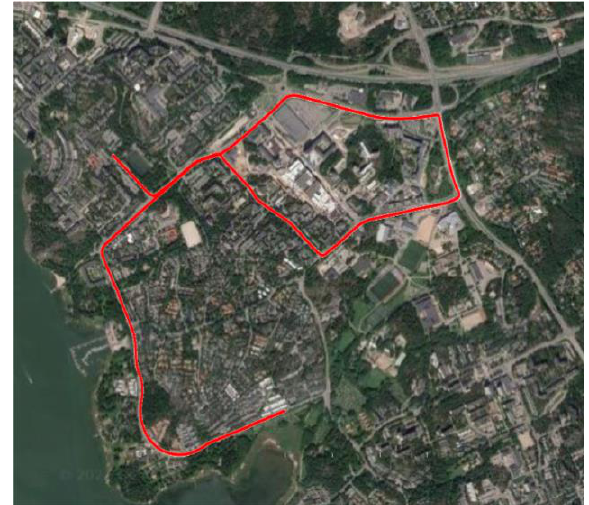
Figure 8 . The ground truth of the kinematic car-borne experiment in Espoo. The red line indicates the real trajectory of the vehicle during the kinematic car-borne experiment.